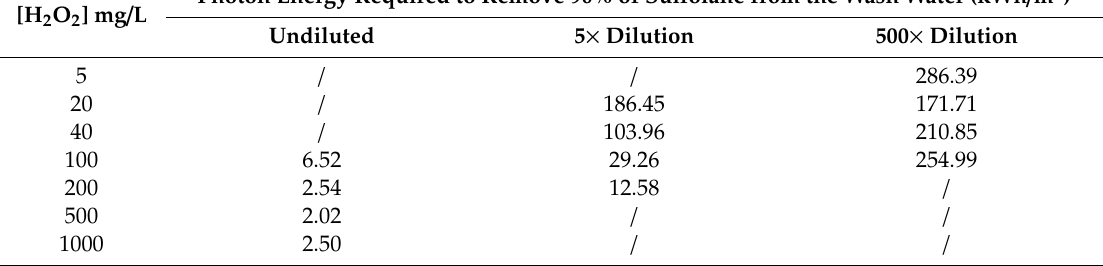
Table 4. Photon energy required to remove 90% of sulfolane from the original soil wash water under di ff erent dilution